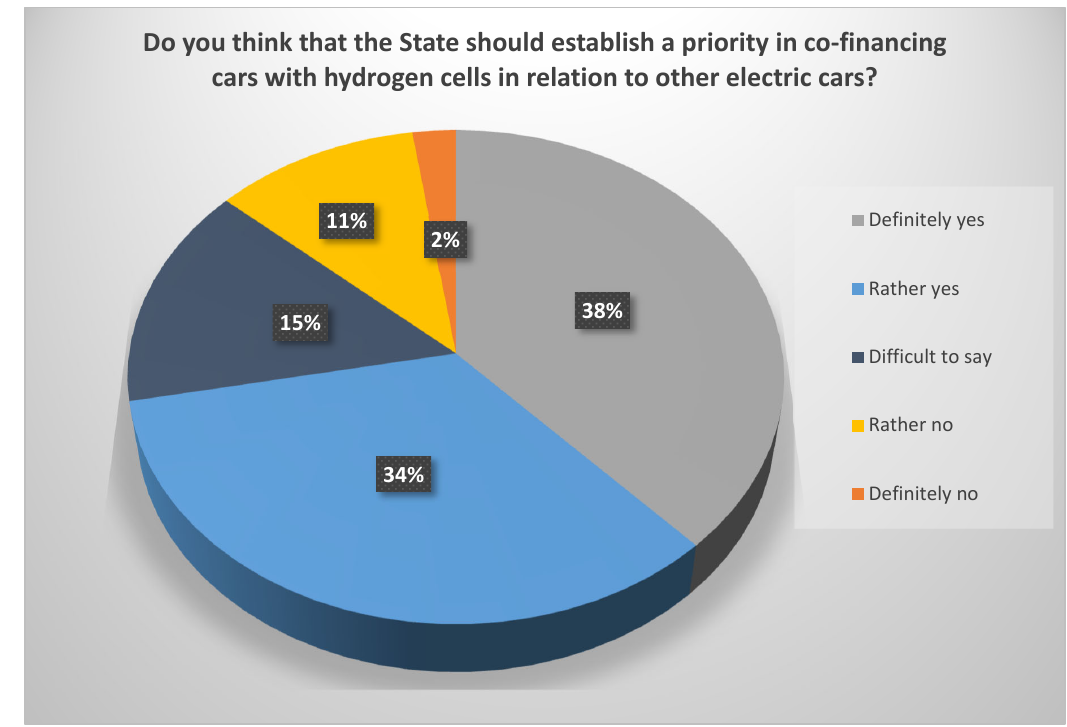
Figure 7. Survey question number 7. Source: own study. Energies 2021 , 14 , x FOR PEER REVIEW